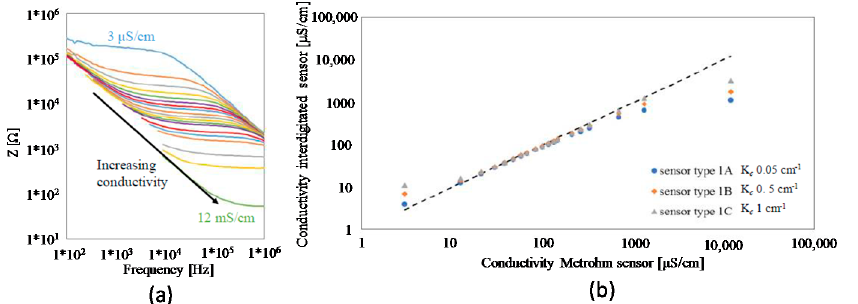
Figure 2. ( a ) Impedance spectra for sensor type 1B ( b ) Conductivity determined at a measurement frequency of 24 kHz plotted against the conductivity values measured with the Metrohm sensor for all three 2-electrode sensors. The dashed line represents the line y = x, with unity